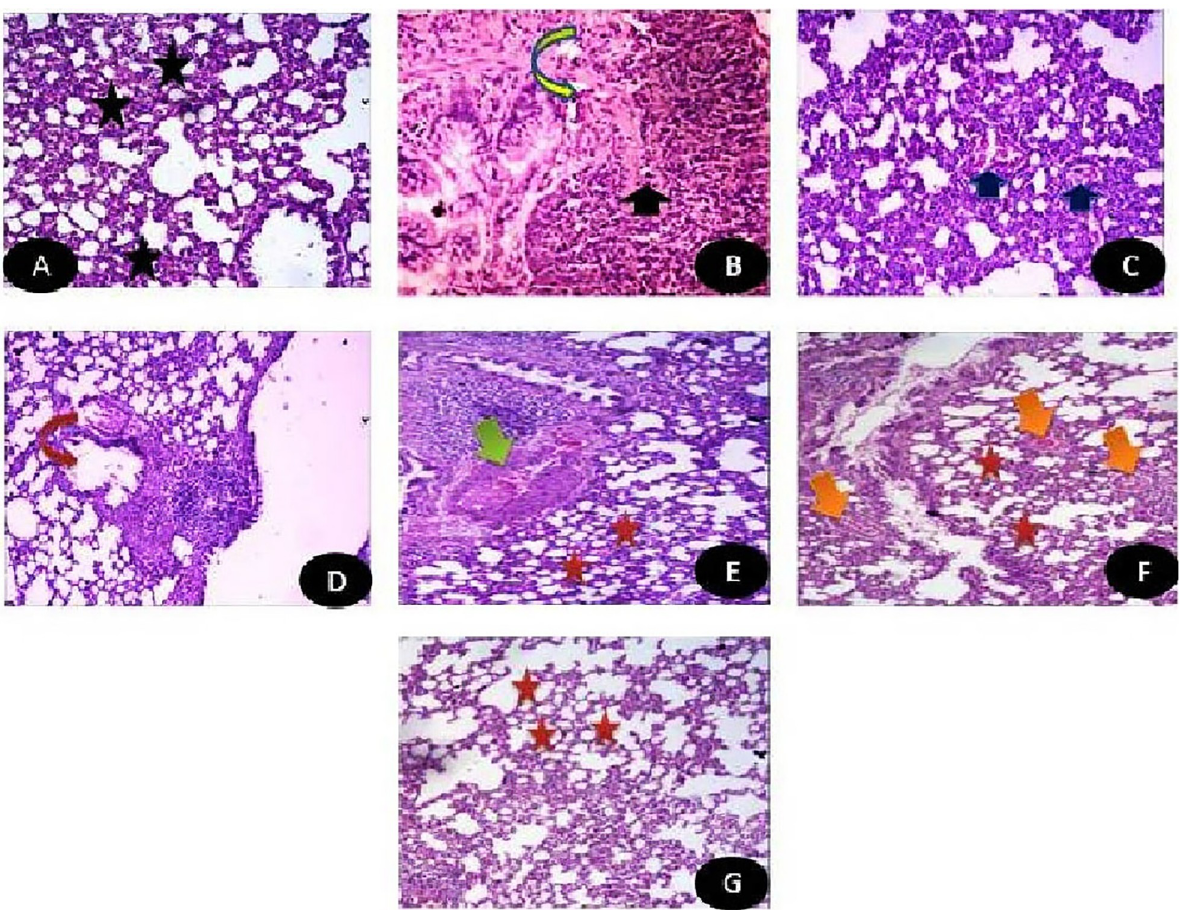
Fig 12. Photomicrograph of Lung tissues showing (A) Control group: Normal lung parenchyma (H&E X400). (B) STZ group: Lung tissues showing dense aggregates of chronic inflammatory cells (Black arrow) with appearance of some necrotic areas (inverted yellow arrow) (H&E X400). (C) STZ + stem cells: Lung tissues with mild improvement with appearance of mild interstitial inflammation (Blue arrow) (H&E X400). (D) STZ+Q: Lung tissues showing normal alveolar walls with mild emphysematous changes (inverted red arrow) (H&E X400). (E) STZ + Q/Zn showing pulmonary parenchyma within normal structure (Red star) with little reactive hyperplasia of submucosal lymphoid tissues (Green arrow) (H&E X400). (F) STZ + Q+ stem cells showing normal pulmonary parenchyma with in some hyperplasia of some lymphoid tissues (Orange arrow) (H&E X400).(G) STZ +Q/Zn+ stem cells showing pulmonary parenchyma within almost normal structure with very mild enlargement in air spaces (Red star) (H&E X400).